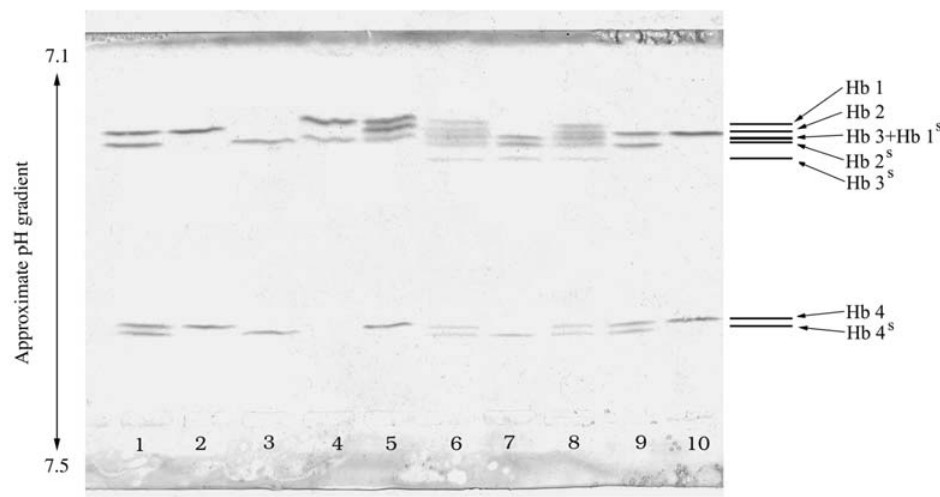
Figure1 -IsoelectricfocusingoftheriverbuffalohemoglobinonimmobilizedpHgradients(7.1-7.5).Lanes1and9-heterozygoteBB s ;lanes2and10- homozygote BB; lane 3 - homozygote B s B s ; lane 4 - homozygote AA; lanes 5 - heterozygote AB; lanes 6 and 8 - heterozygote ABA s B s ; lane 7 - heterozygote A s B s . Superscript “s” assigned to Hb and its phenotypes indicates the presence of one of the two variant β -globin chain.